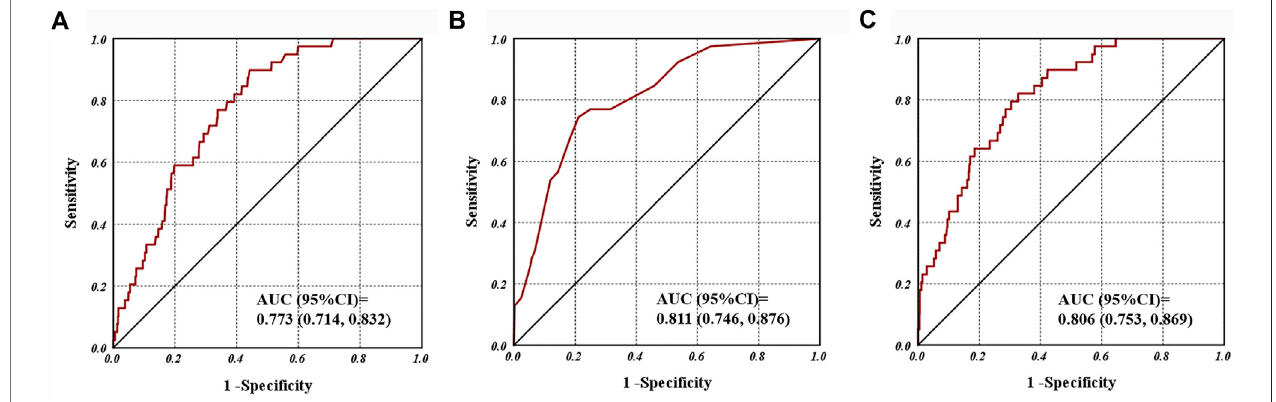
FIGURE 2 | Receiver operating characteristic curves for (A) post-operative serum procalcitonin; (B) model 1; (C) and model 2 associated with post-hepatectomy liver failure.